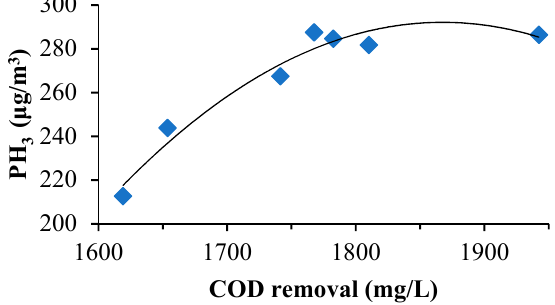
Figure 4. The correlation between the COD removal and the phosphine production.